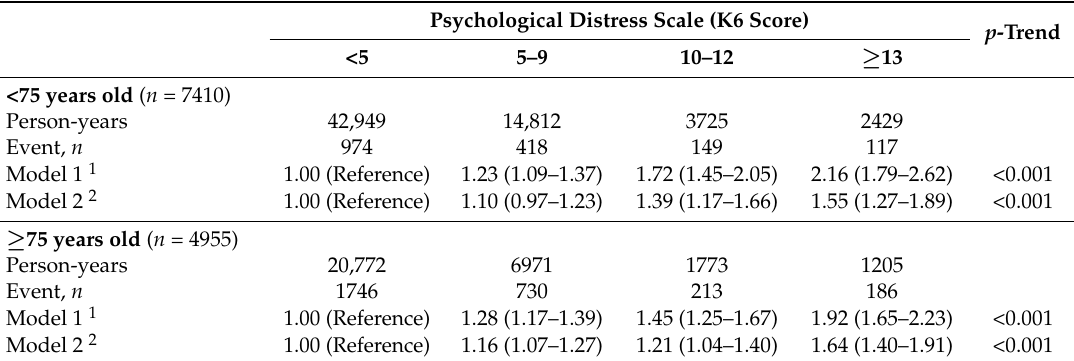
Table 4. Sensitivity analysis: stratified by age subgroup.